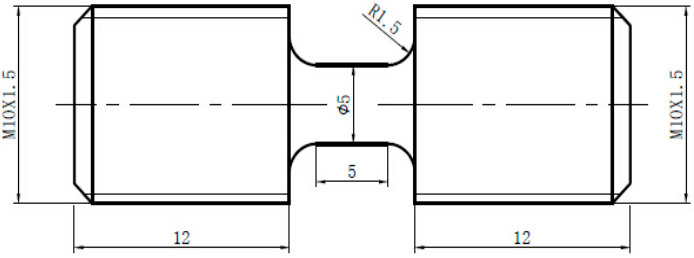
Figure 1. Geometry and dimension of the specimen for SHTB test.